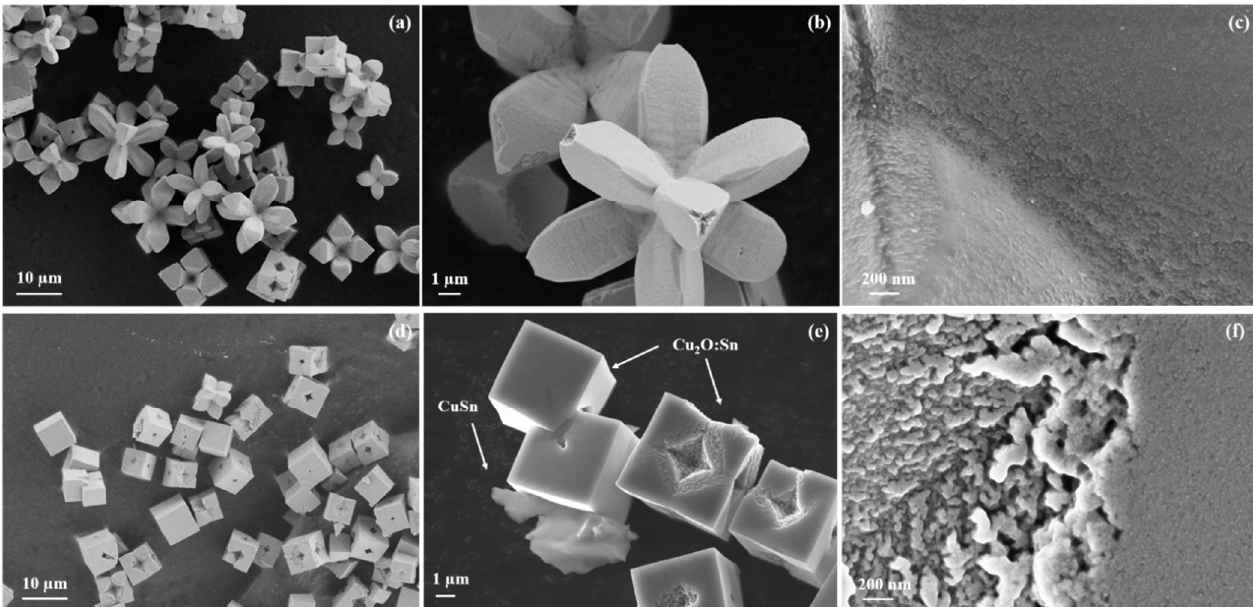
Figure 2. FESEM images of the samples. ( a – c ) Cu 2 O, ( d – f ) Sn-Cu 2